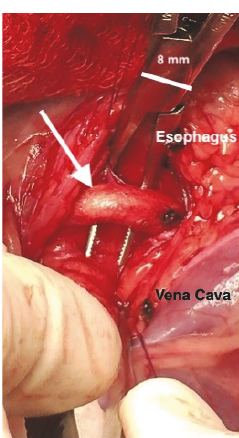
Figure 3: Aberrant right aortic arch seen via right 4th lateral thoracotomy (white arrow). The dilated esophagus can be seen at the top of the figure behind the right-angle forceps with the cranial vena cava at the bottom right.